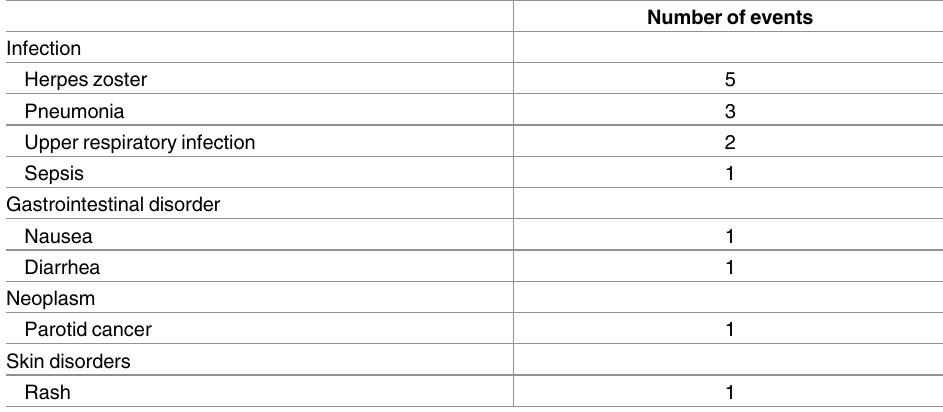
Table 2. Adverse